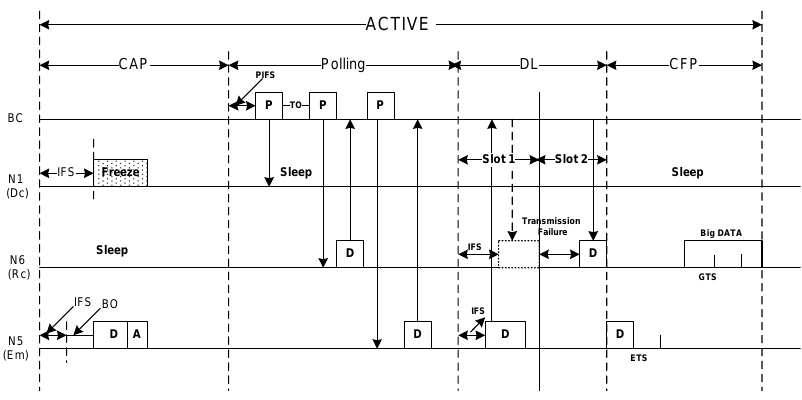
Figure 10. Emergency data transmission during ACTIVE